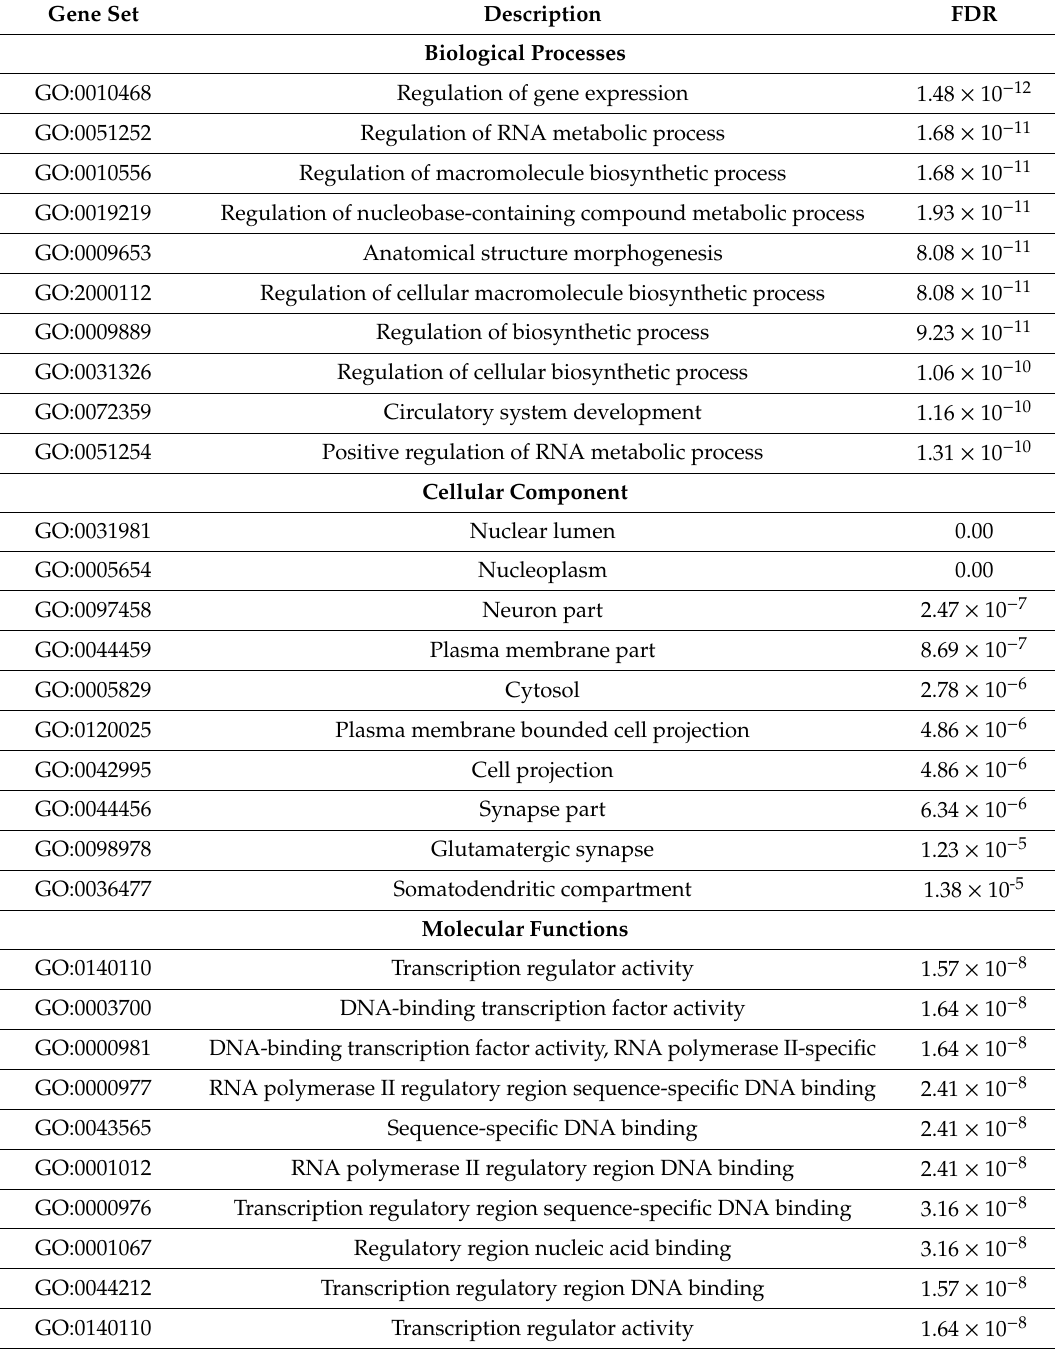
Table 2. List of the top 10 identified gene ontology (GO) terms and false discovery rate (FDR) using target genes of upregulated miRNAs at 4 h post-systemic ovine LPS